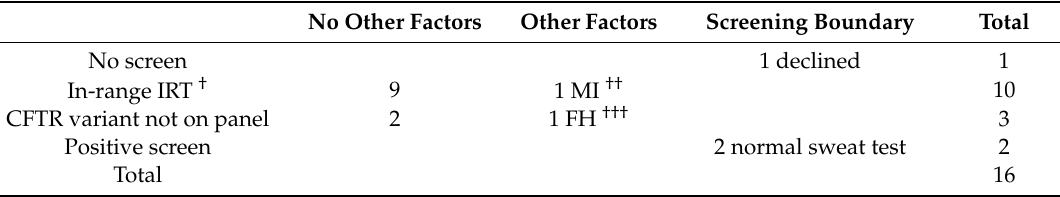
Table 1. Clinically diagnosed cystic fibrosis, Auckland region 2003–2017. No Other Factors Other Factors Screening